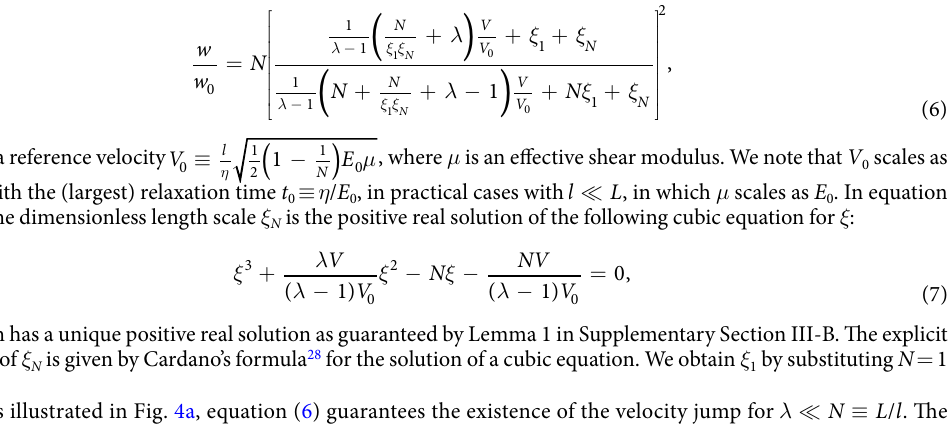
Figure 3. Three types of dynamic responses of a Zener element: soft-elastic, viscoelastic, and hard-elastic responses. ( a ) Dynamical response of a Zener element to adequately slow or fast stretch (see, text). ( b ) Dynamic modulus E ( ω ) = Re E ( ω ) + i Im E ( ω ) as a function of an angular frequency of strain oscillation ω in a Zener element. Here, Re E ( ω ) and Im E ( ω ) are the storage and loss moduli, respectively. We plot E ( ω ) = E 0 (1 + i ω t slow )/ (1 + i ω t fast ) obtained from the stress-strain relation in equation (4), with η ∞  t E / (rubbery) soft-elastic and (glassy) hard-elastic regimes, the dynamics are elastic and characterized by E 0 and E ∞ , respectively, whereas in the viscoelastic regime the dynamics is governed by η , E 0 , and E ∞ Exact analytical relation between w and V .